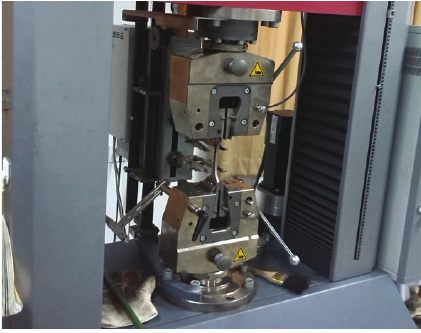
Figure 3: Specimen size.